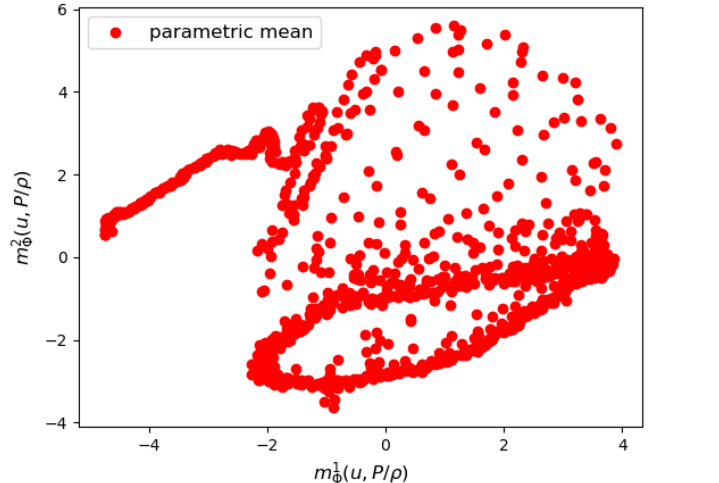
Figure 6. Mesh n°1: The first two components of the parametrized mean of the VAE encoder.